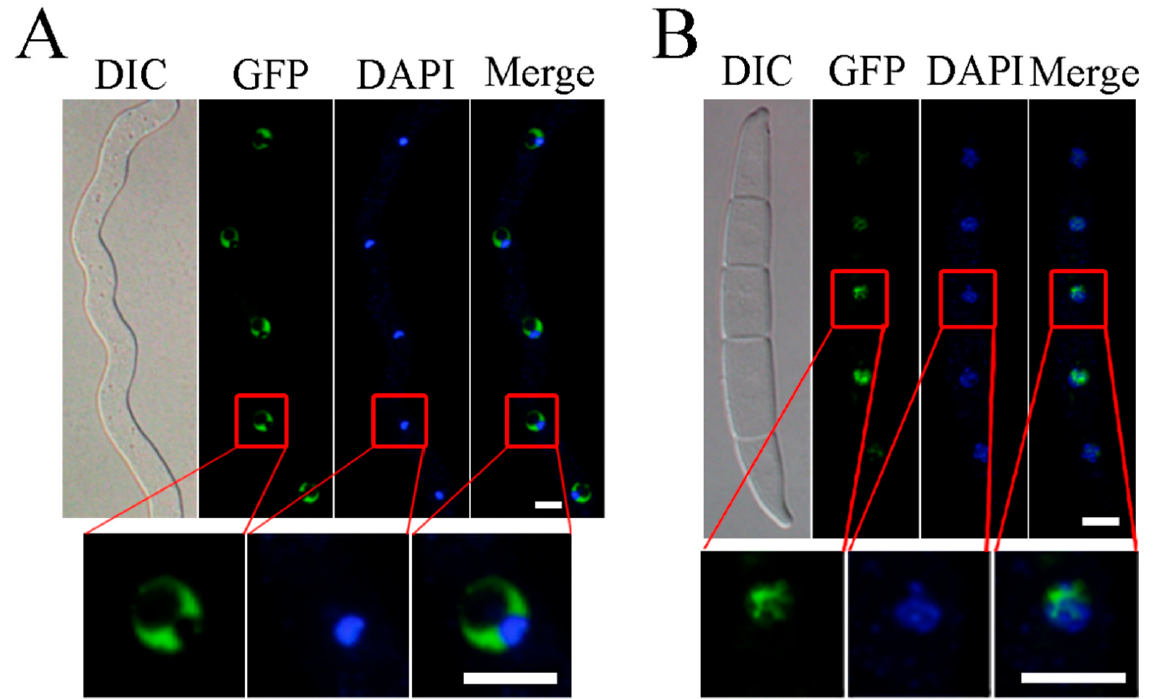
Figure 5. The subcellular localization of the FgCsn12-GFP fusion protein. ( A ) Germlings of trans- formant CG1 were stained with DAPI and examined by DIC or epifluorescence microscopy (GFP). Bar = 5 µ m. ( B ) Conidia of transformant CG1 were stained with DAPI and examined by DIC or epifluorescence microscopy. Bar = 10 μ m.